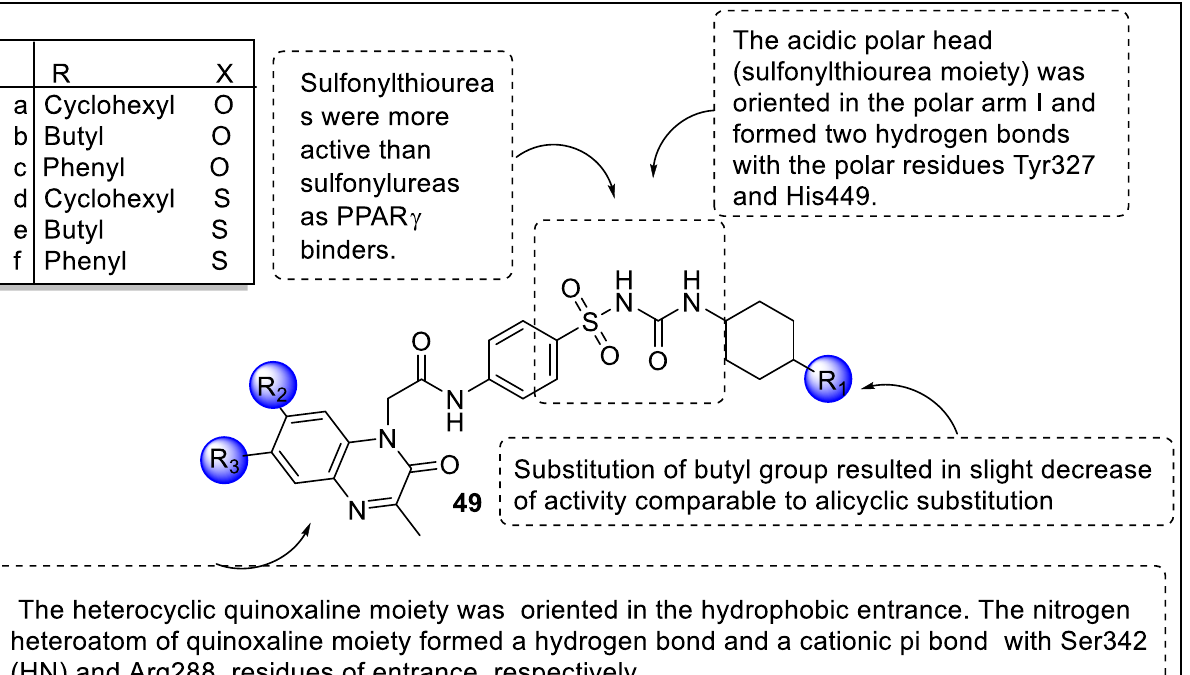
Figure 53. Structural activity relationship of quinoxaline hybrids ( 49 ) as potent PPAR ligands.